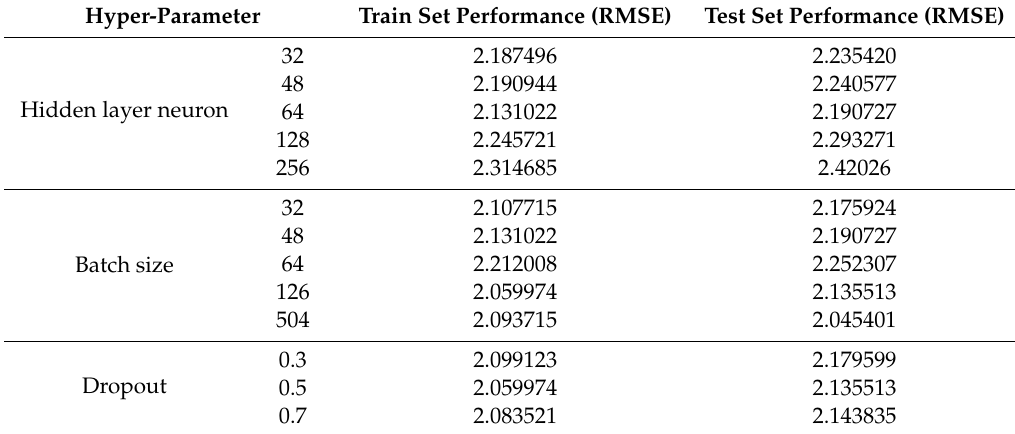
Table 2. E ff ect of di ff erent parameter settings on model fitting e ff ect / dB(A).